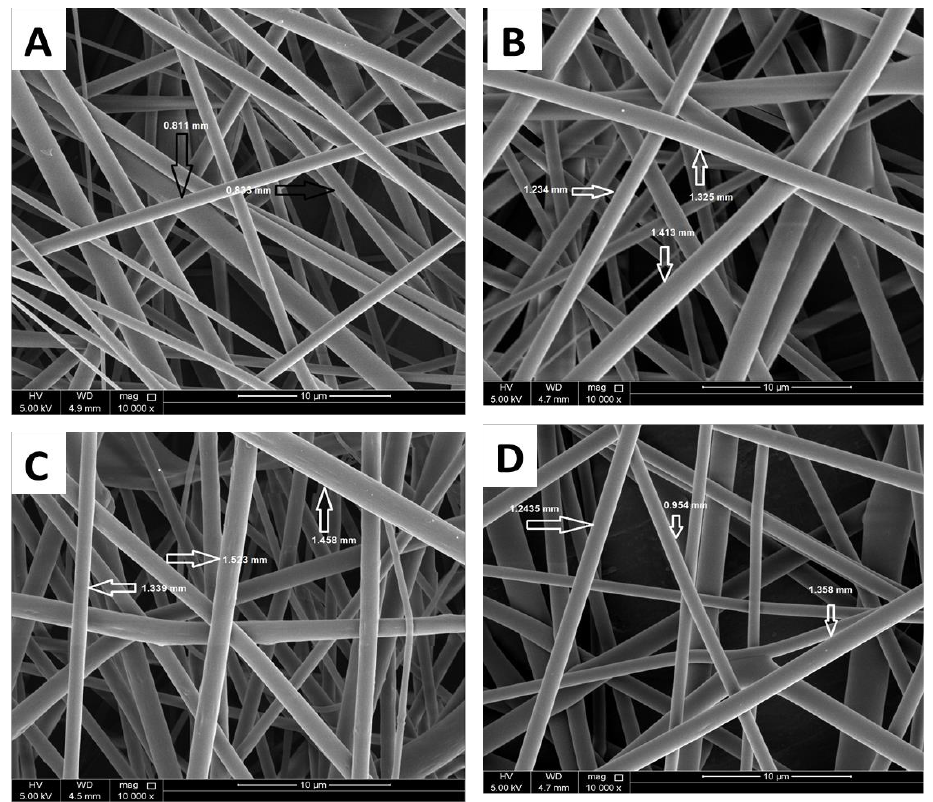
Figure 1. SEM images of copolyamide-HA composite nanofibers ( A ) 0% HA ( B ) 0.5% HA ( C ) 1% HA, and ( D ) 1.5% HA.